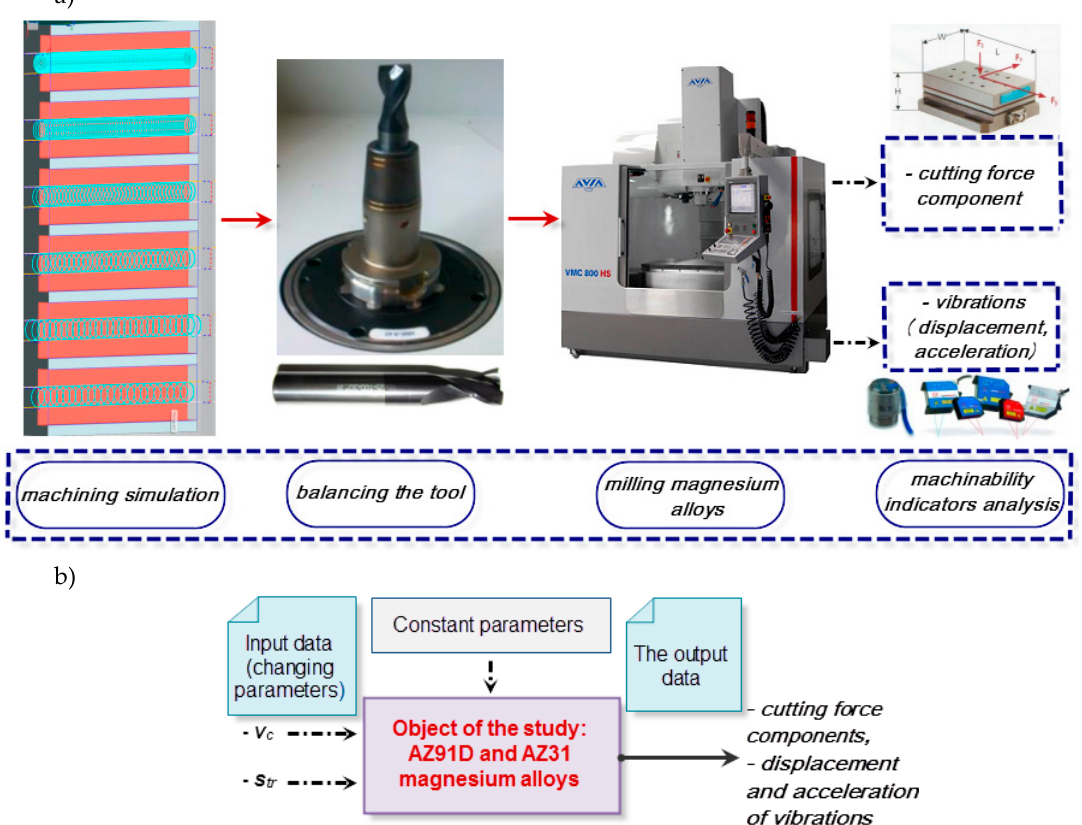
Figure 1. Schematic diagram ( a ) and test set-up ( b ) with the object of the study